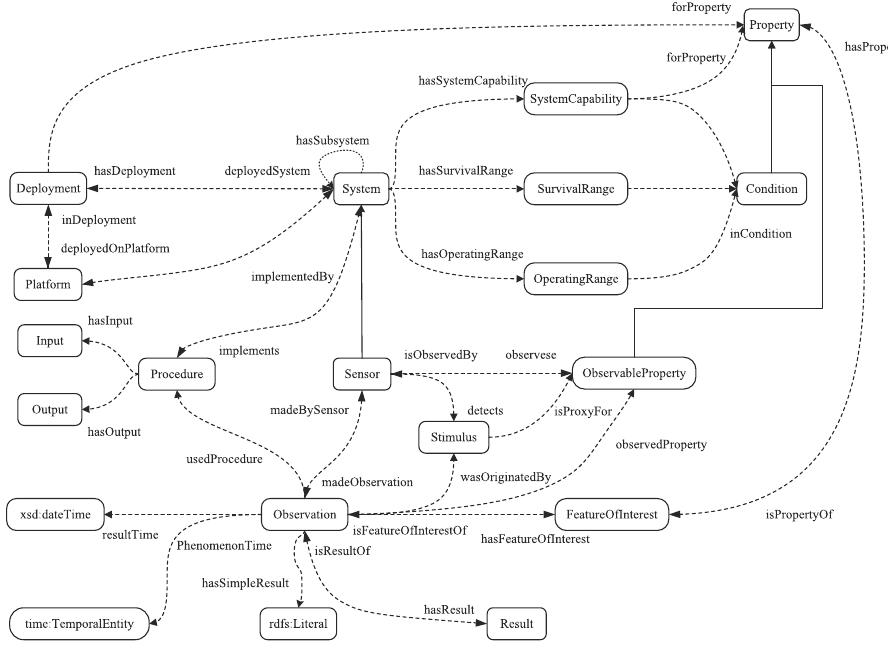
Fig. 1 An example of sensor ontology: contains class and